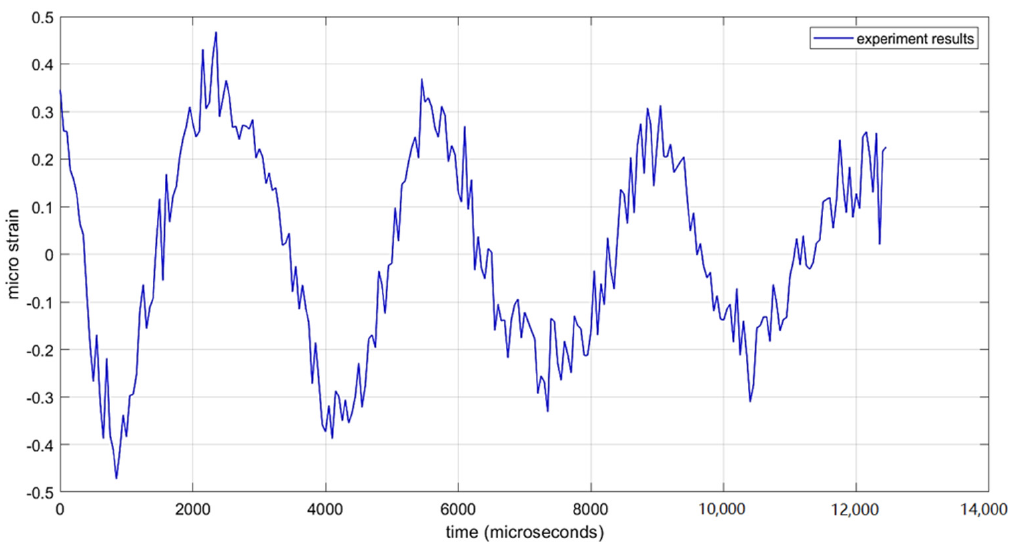
Figure 7. Experimental strain vs. time data plotted in MATLAB ® (natural response after the ball is removed).